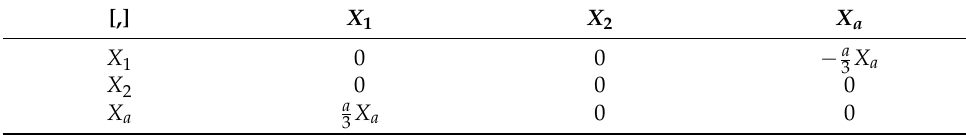
Table 4. Lie brackets for Case 3.